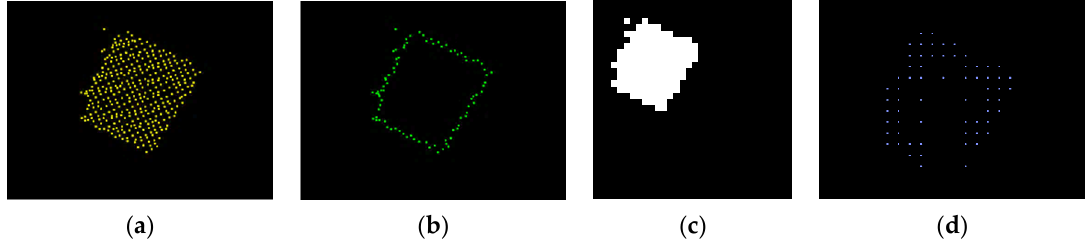
Figure 5. Simplification results of plane point cloud: ( a ) original plane point cloud, ( b ) boundary point cloud in green, ( c ) grayscale image, and ( d ) simplified plane point cloud ( Pl s